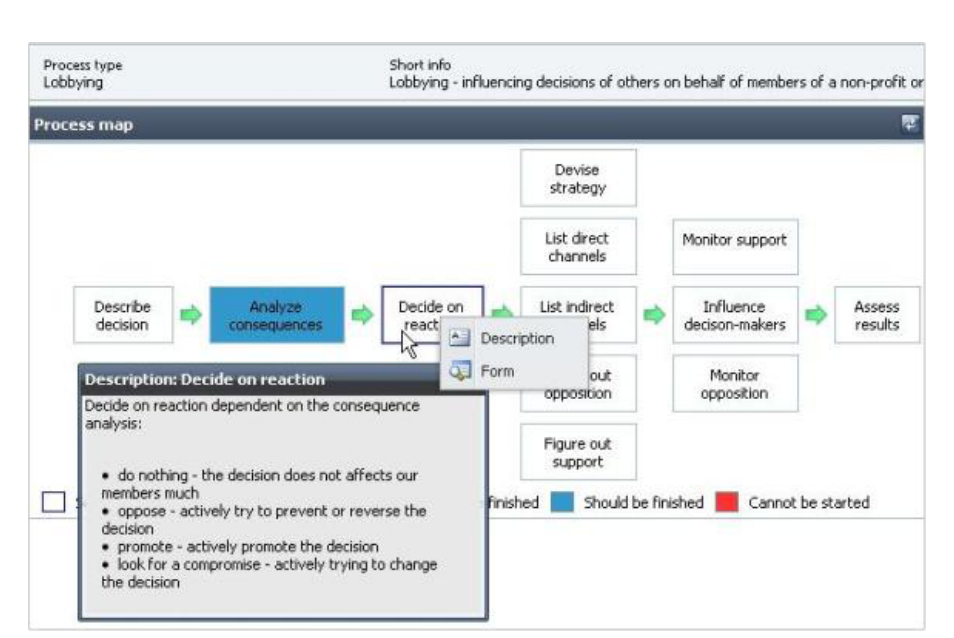
Figure 7. A process map representing a situational structure